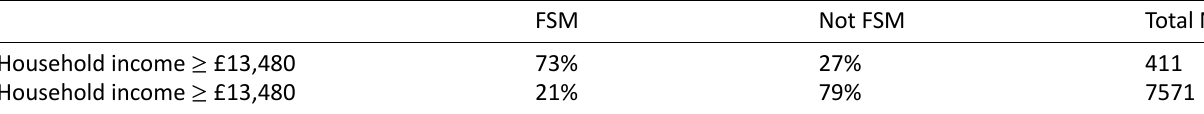
Table 5. Comparison of FSM status and household income in linked dataset.